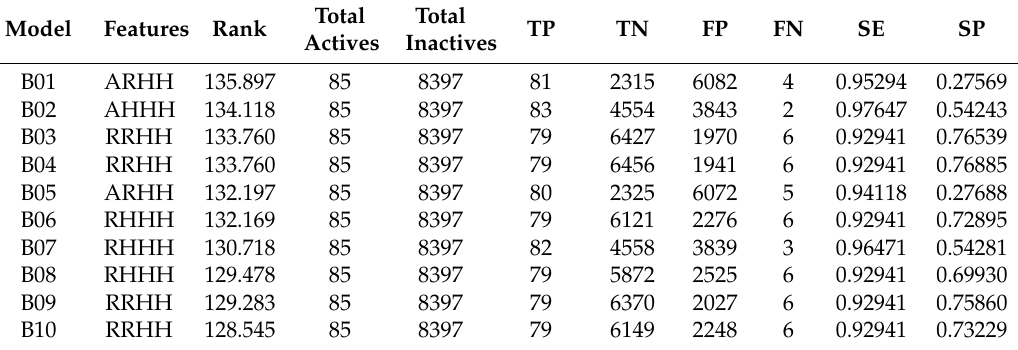
Table 2. Feature set, selectivity score, and validation results of the ligand-based pharmacophore